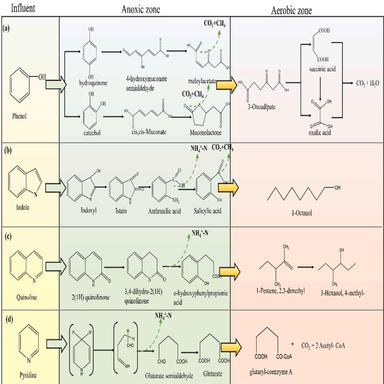
Proposed AOCs degradation pathways.